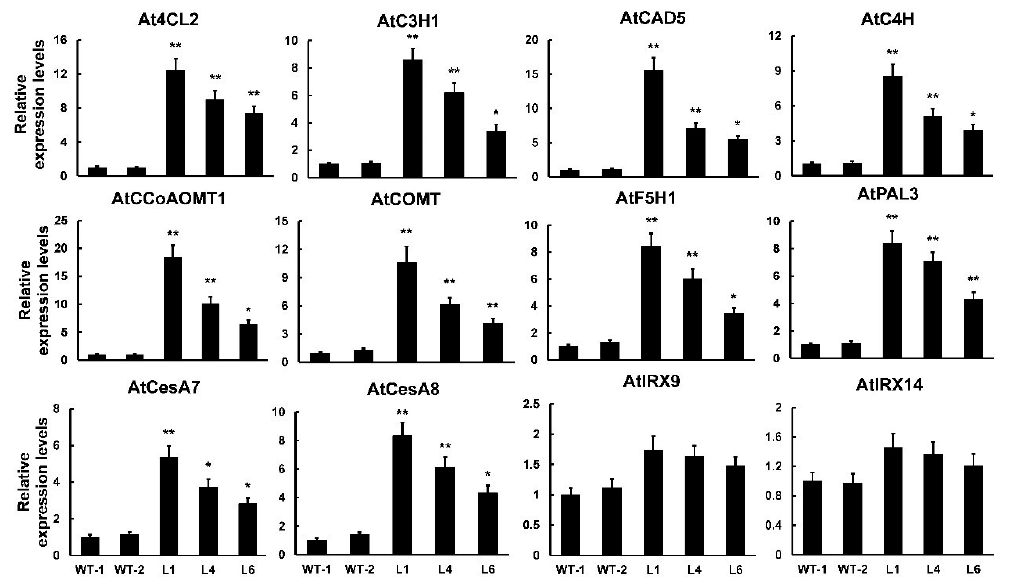
Figure 6. Expression profiles of SCW biosynthetic genes in WT and PtrMYB121 -overexpressing plants. 4CL2 , C3H1 , CAD5 , C4H , CCoAOMT1 , COMT , F5H1, and PAL3 : lignin biosynthetic genes. CesA7 and CesA8 : cellulose biosynthetic genes. IRX9 and IRX14 : hemicellulose biosynthetic